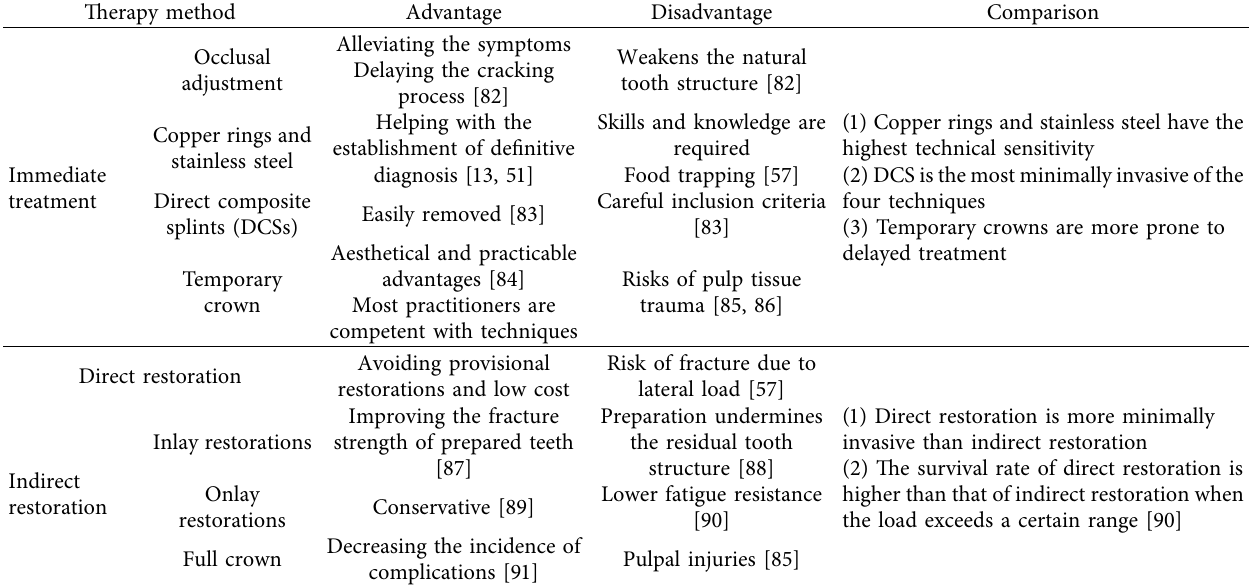
Table 3: Therapy methods and, accordingly, their advantages, disadvantages, and